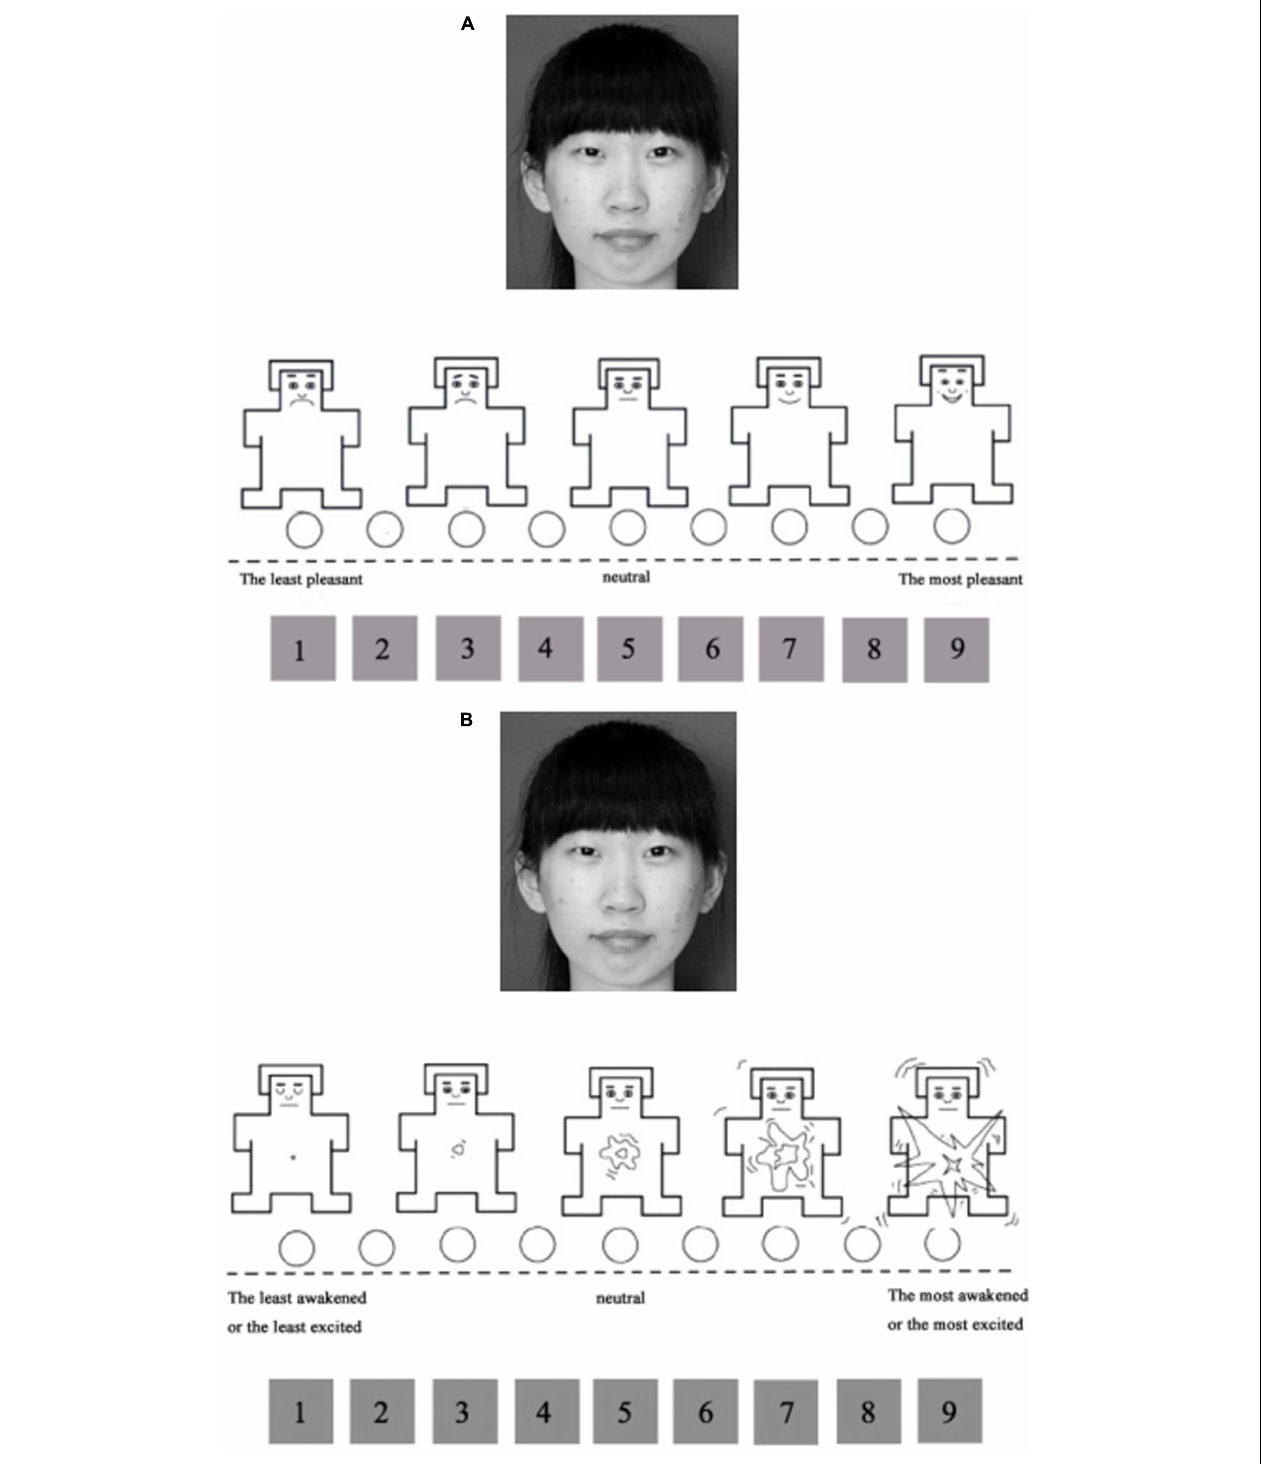
FIGURE 1 | (A) The rating scale for pleasure. A face and the scale were presented at the same time. The characteristics of the cartoon figures in the picture represented different levels of pleasure. Regarding the numbers below the face, 1 indicated that the face made the participant feel the most unpleasant, 5 meant neutral, and 9 meant the face made the participant feel the most pleasant. (B) The rating scale for arousal. A face and the scale were presented at the same time. The characteristics of the cartoon figures in the picture represented different levels of arousal. Regarding the numbers below the face, 1 indicated that the face made the participant feel the least awakened, excited, and tense, 5 meant neutral, and 9 meant that the face made the participant feel the most awakened, excited, and tense.